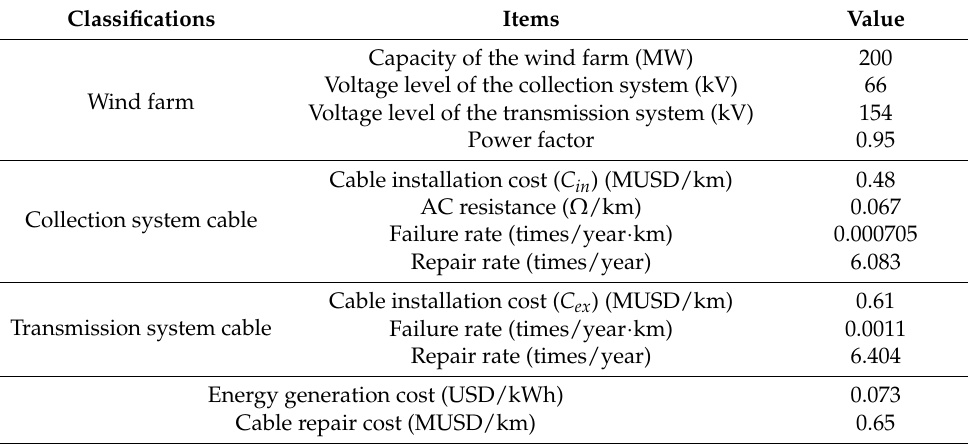
Table 12. Data for calculating the OPEX of the FOWF.